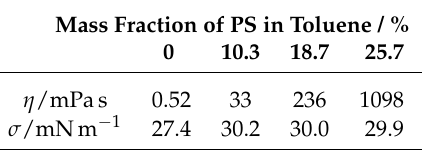
Table 2. Influence of polymer concentration on material properties of PS-toluene solutions ( M W,PS = 299kgmol − 1 ) [41].